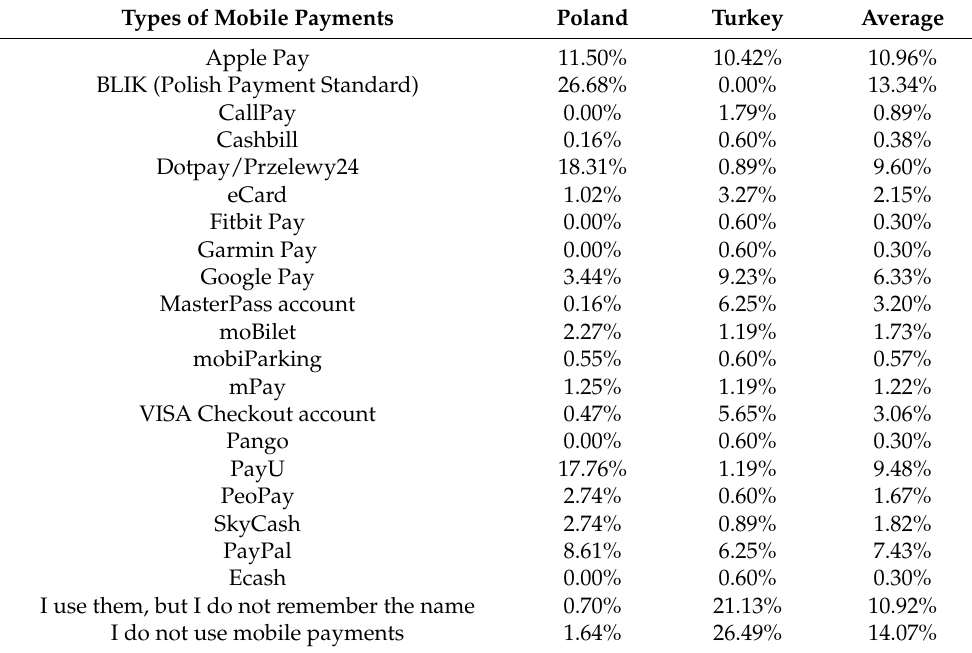
Table 4. Mobile payment solutions used in Poland and Turkey; source: own work.